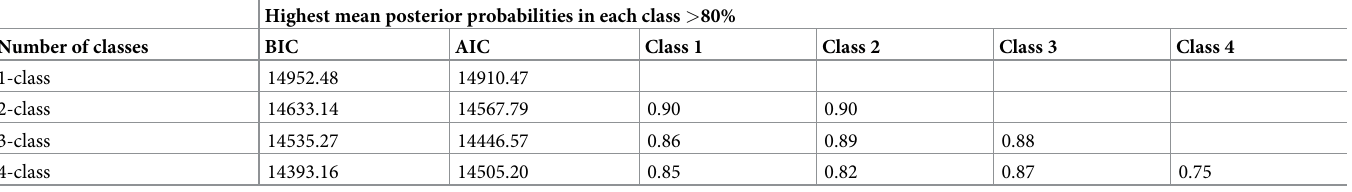
Table 2. Bayesian and Akaike Information Criterion and mean posterior probability